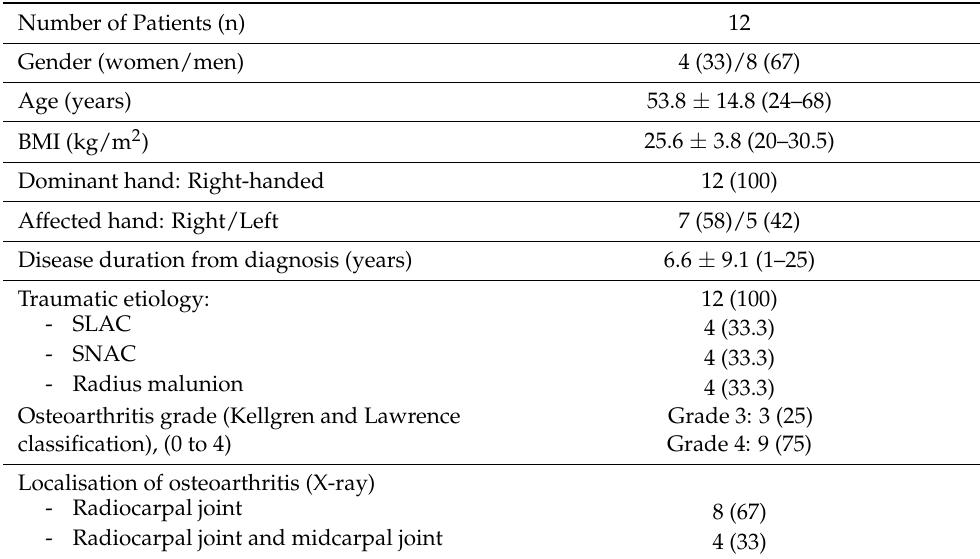
Table 2. Baseline Characteristics of